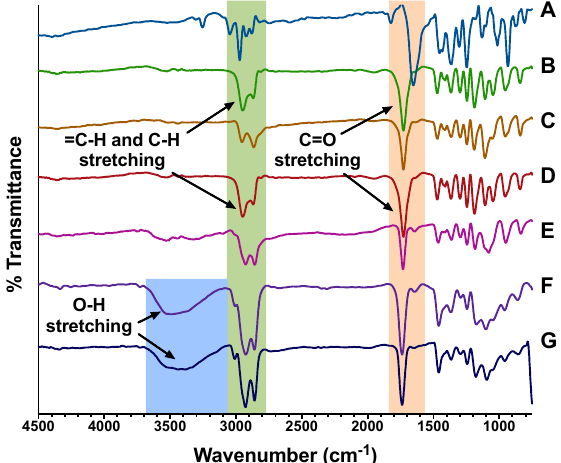
Figure4. FT-IR spectra of( A ) TQ, ( B ) mPEG5K-PCL10.3K, ( C ) mPEG5K-PCL18.5K, ( D ) F1-NS, ( E ) F2-NS, Figure 4. FT-IR spectra of ( A ) TQ, ( B ) mPEG5K-PCL10.3K, ( C ) mPEG5K-PCL18.5K, ( D ) F1-NS, ( E ) F2- ( F ) F1-NC, and ( G ) F2-NC. TQ exhibited = C–H, C–H, and C = O stretching at 3050 cm − 1 , 2970 cm − 1 NS, ( F ) F1-NC, and ( G ) F2-NC. TQ exhibited =C–H, C–H, and C=O stretching at 3050 cm − 1 , 2970 cm − 1 ,